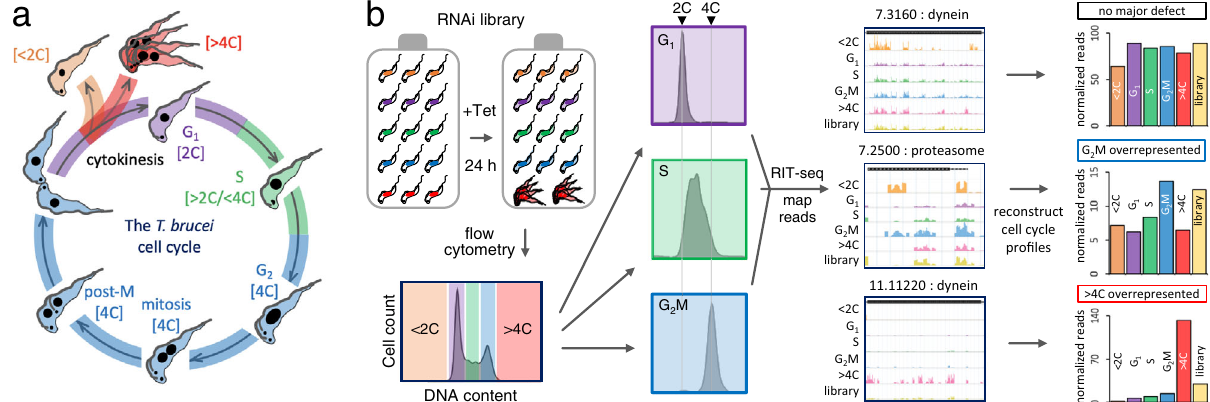
Fig.1|Agenome-wideconditionalknockdownscreenforcellcycleprogression defects. a Schematic representation of the bloodstream form T. brucei cell cycle, also showing aberrant sub-2C and >4C (multiple nuclei) phenotypes; anuclear zoidsarenotshownastheyareundetectablebyRIT-seq. b Theschematicillustrates the RIT-seq screen; massive parallel induction of RNAi with tetracycline (Tet), fol- lowed by fl ow cytometry and RIT-seq, allowing for reconstruction of cell cycle